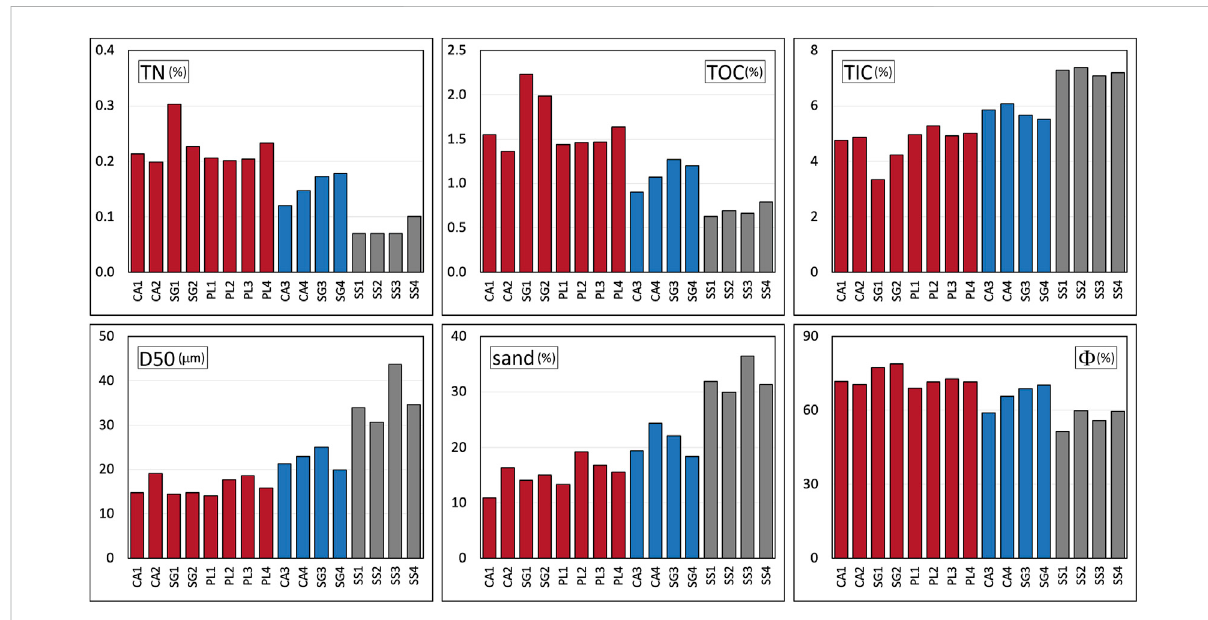
FIGURE 4 TN,TOCandTICconcentrationvalues,D50diameter,sandcontent(63 – 500 μ m)andporosityinthe0 – 2 cmsedimentlayerofthe16sites.Bar coloring highlights the three groups of